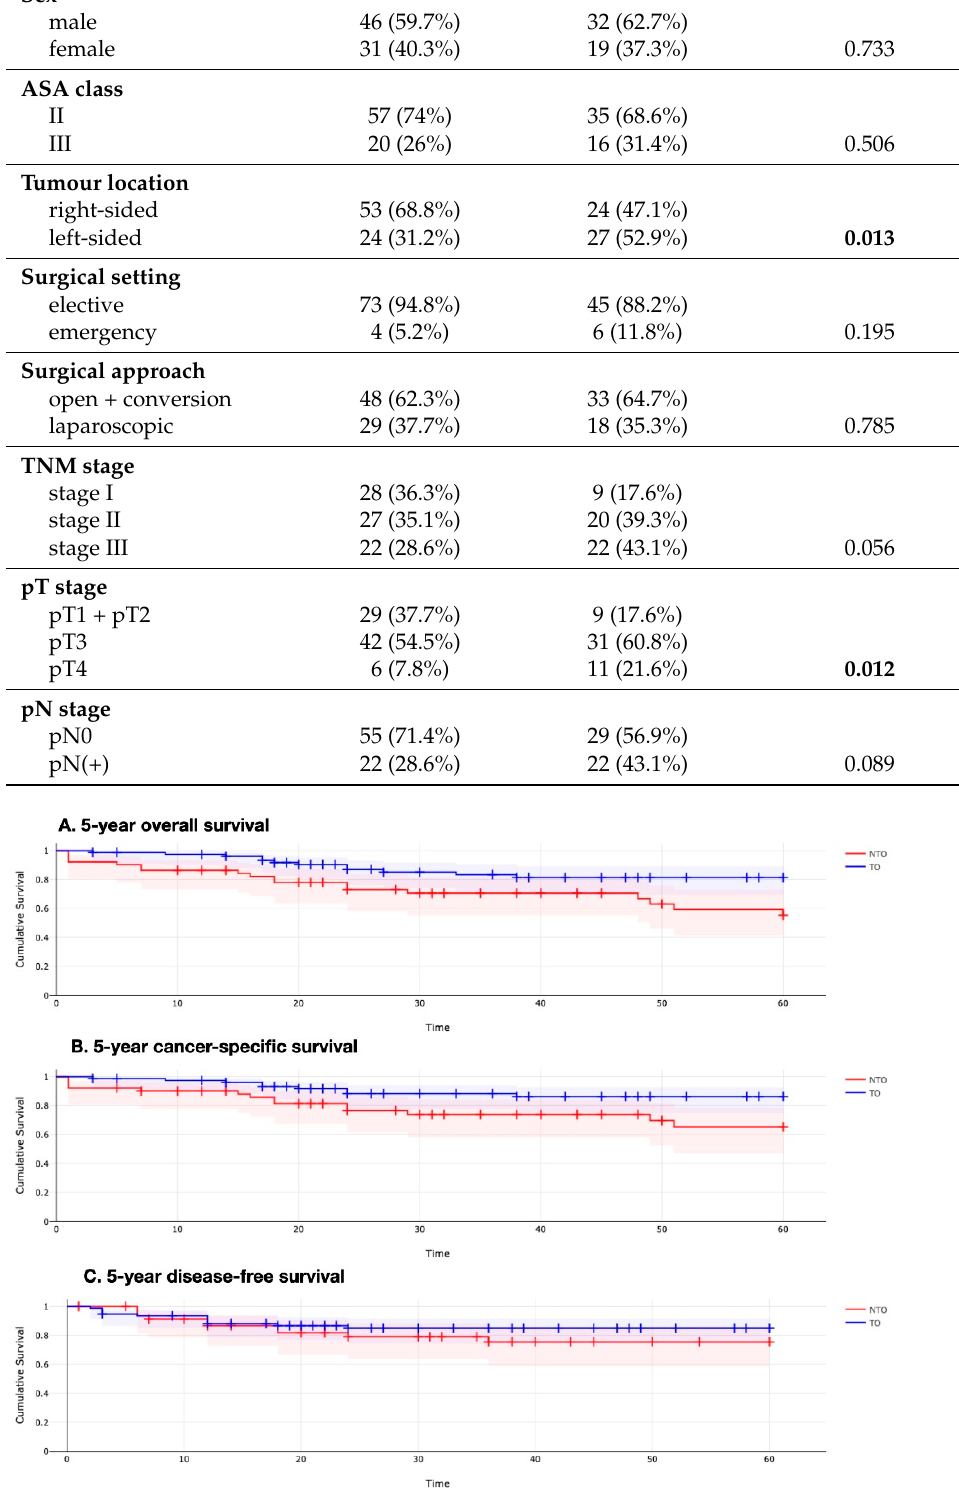
Figure 2. 5-year survival curves between Textbook Outcome (TO) and Non-Textbook Outcome (NTO)